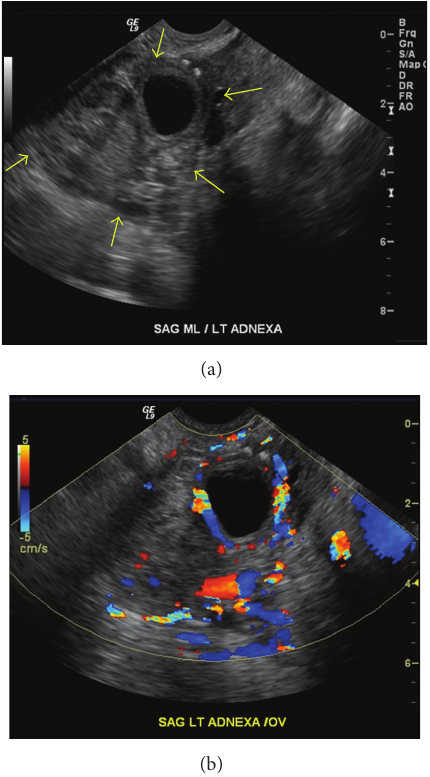
Figure 2: Image (a) is a transvaginal sagittal US image through the left adnexal region which demonstrates a heterogeneous mass (arrows) containing an anechoic cystic structure with slightly echogenic thick walls. Image (b) is a Doppler US image through the same area demonstrating an intense peripheral vascularity with a “ring of fire”